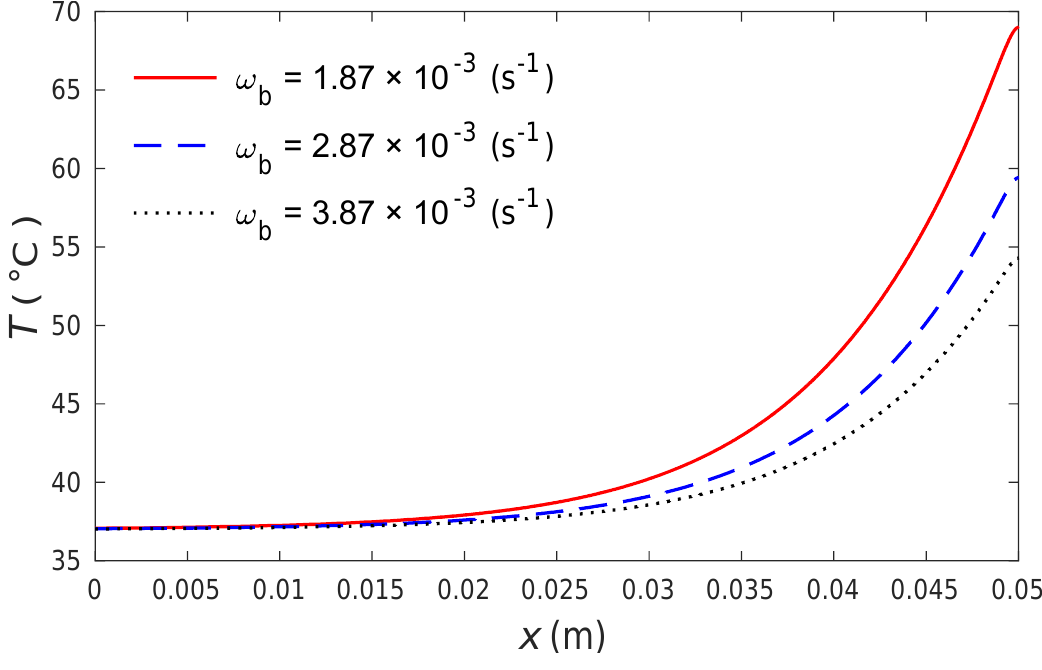
Figure 5. Temperature distributions according to distance for three values of 𝜔 𝑏 .